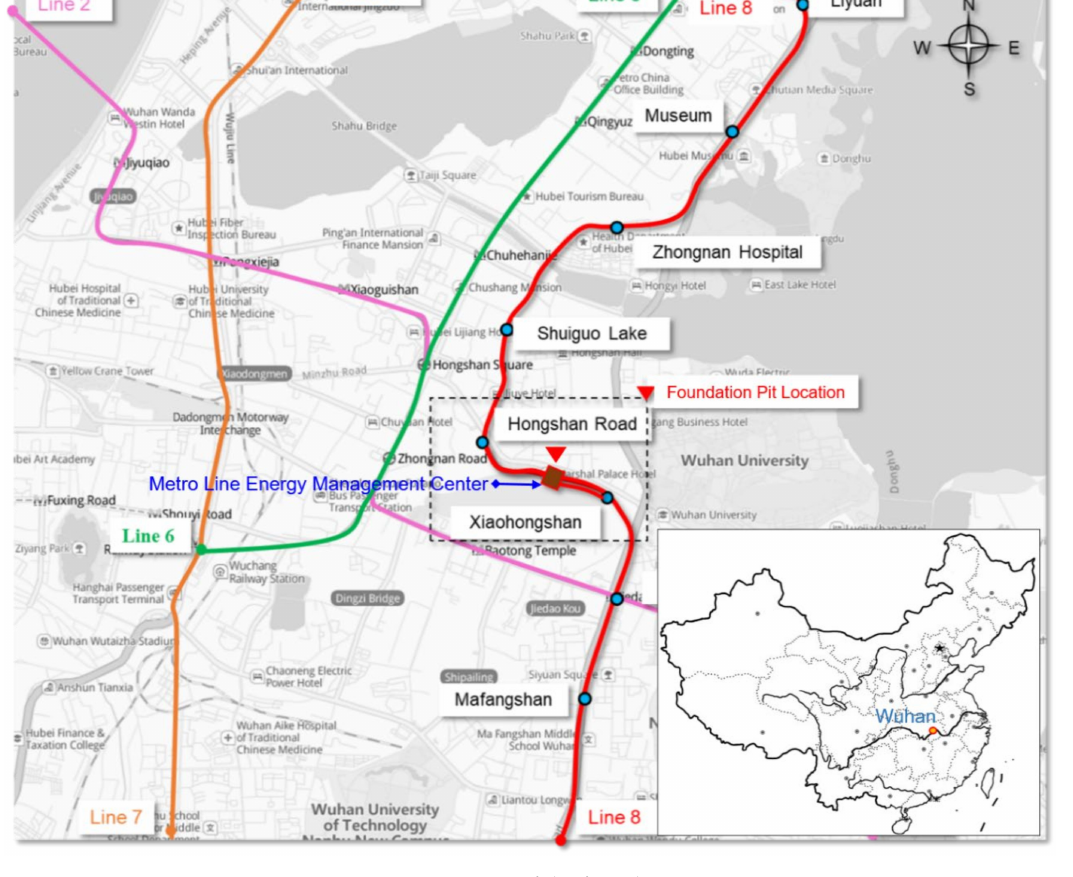
Figure 1. Location of the foundation